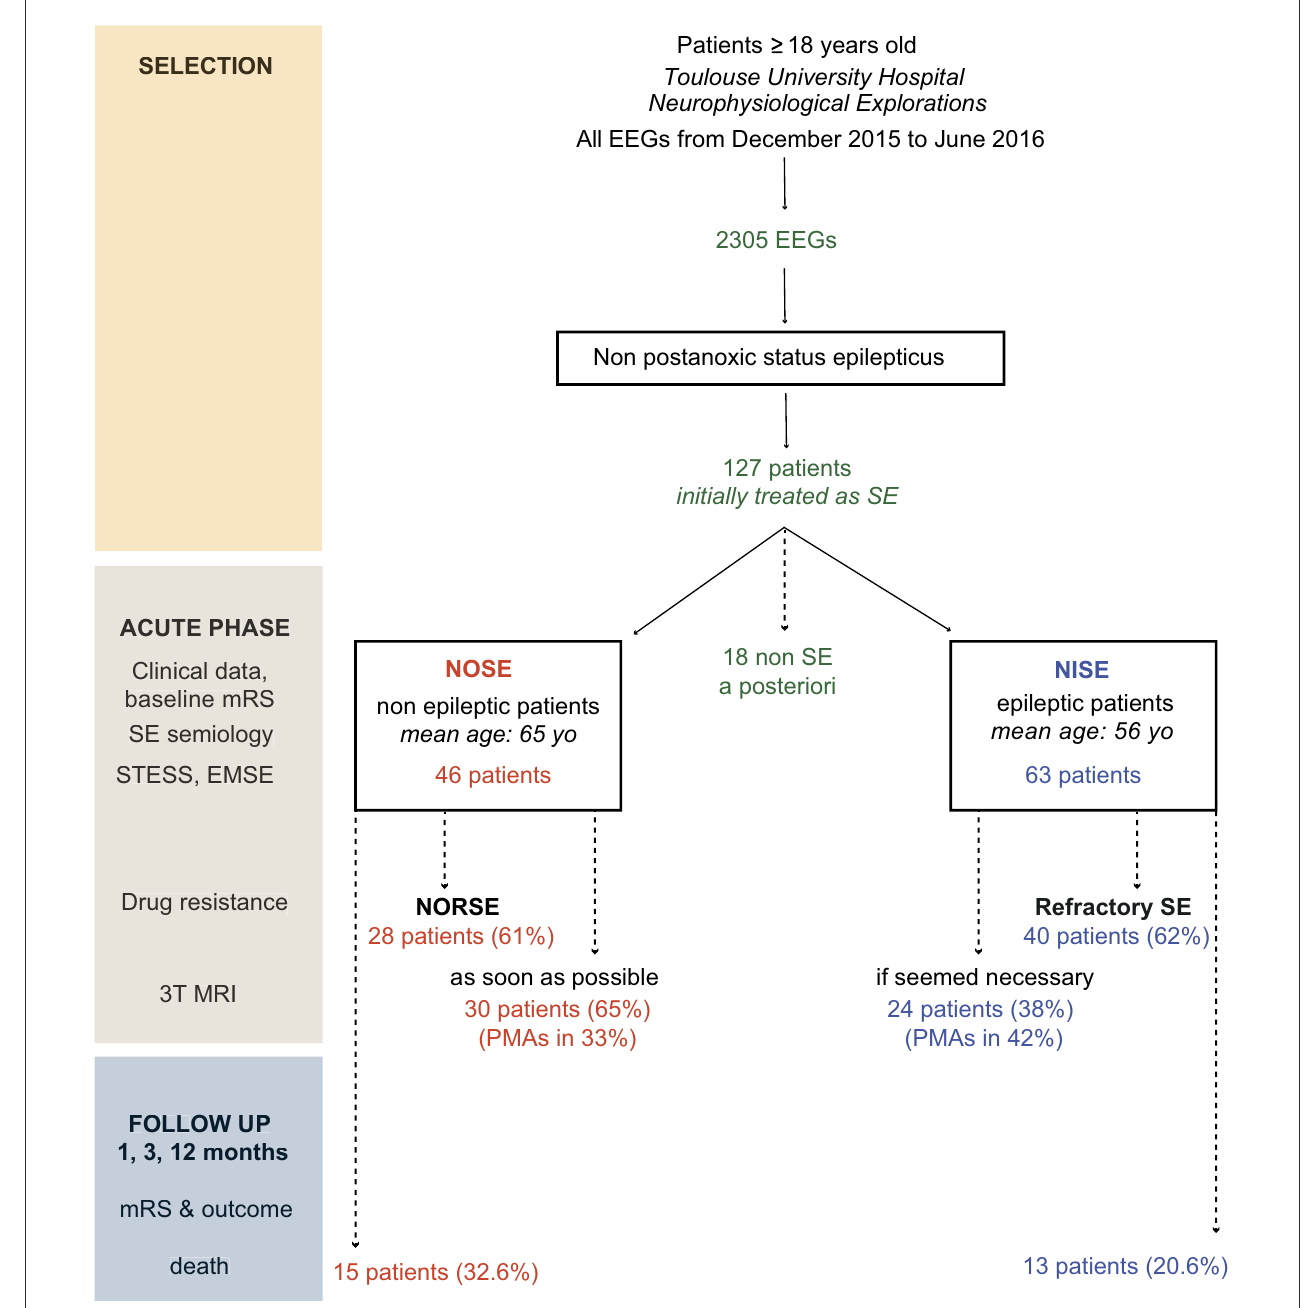
FIGURE1 Study design, selection of patients, and SE classification. Five patients were secondarily excluded from the NOSE group (1 with myoclonus of the left upper limb secondary to spinal cord ischemia, 1 with vigilance fluctuations due to a post-traumatic brainstem lesion, 1 with a reactive coma and abnormal movements secondary to severe intra-parenchymal hemorrhage, 1 with psychomotor agitation and vagal discomfort with the loss of consciousness due to pain, and 1 with a first psychogenic non-epileptic status). A total of 13 patients were secondarily excluded from the NISE group (6 with a psychogenic non-epileptic status, 3 with serial seizures but complete clinical recovery between seizures, 3 with a prolonged post-ictal deficit and/or post-ictal agitation, and 1 with chronic meningitis on ventriculoperitoneal shunt, abnormal eye movements, and intracranial hypertension with no argument for